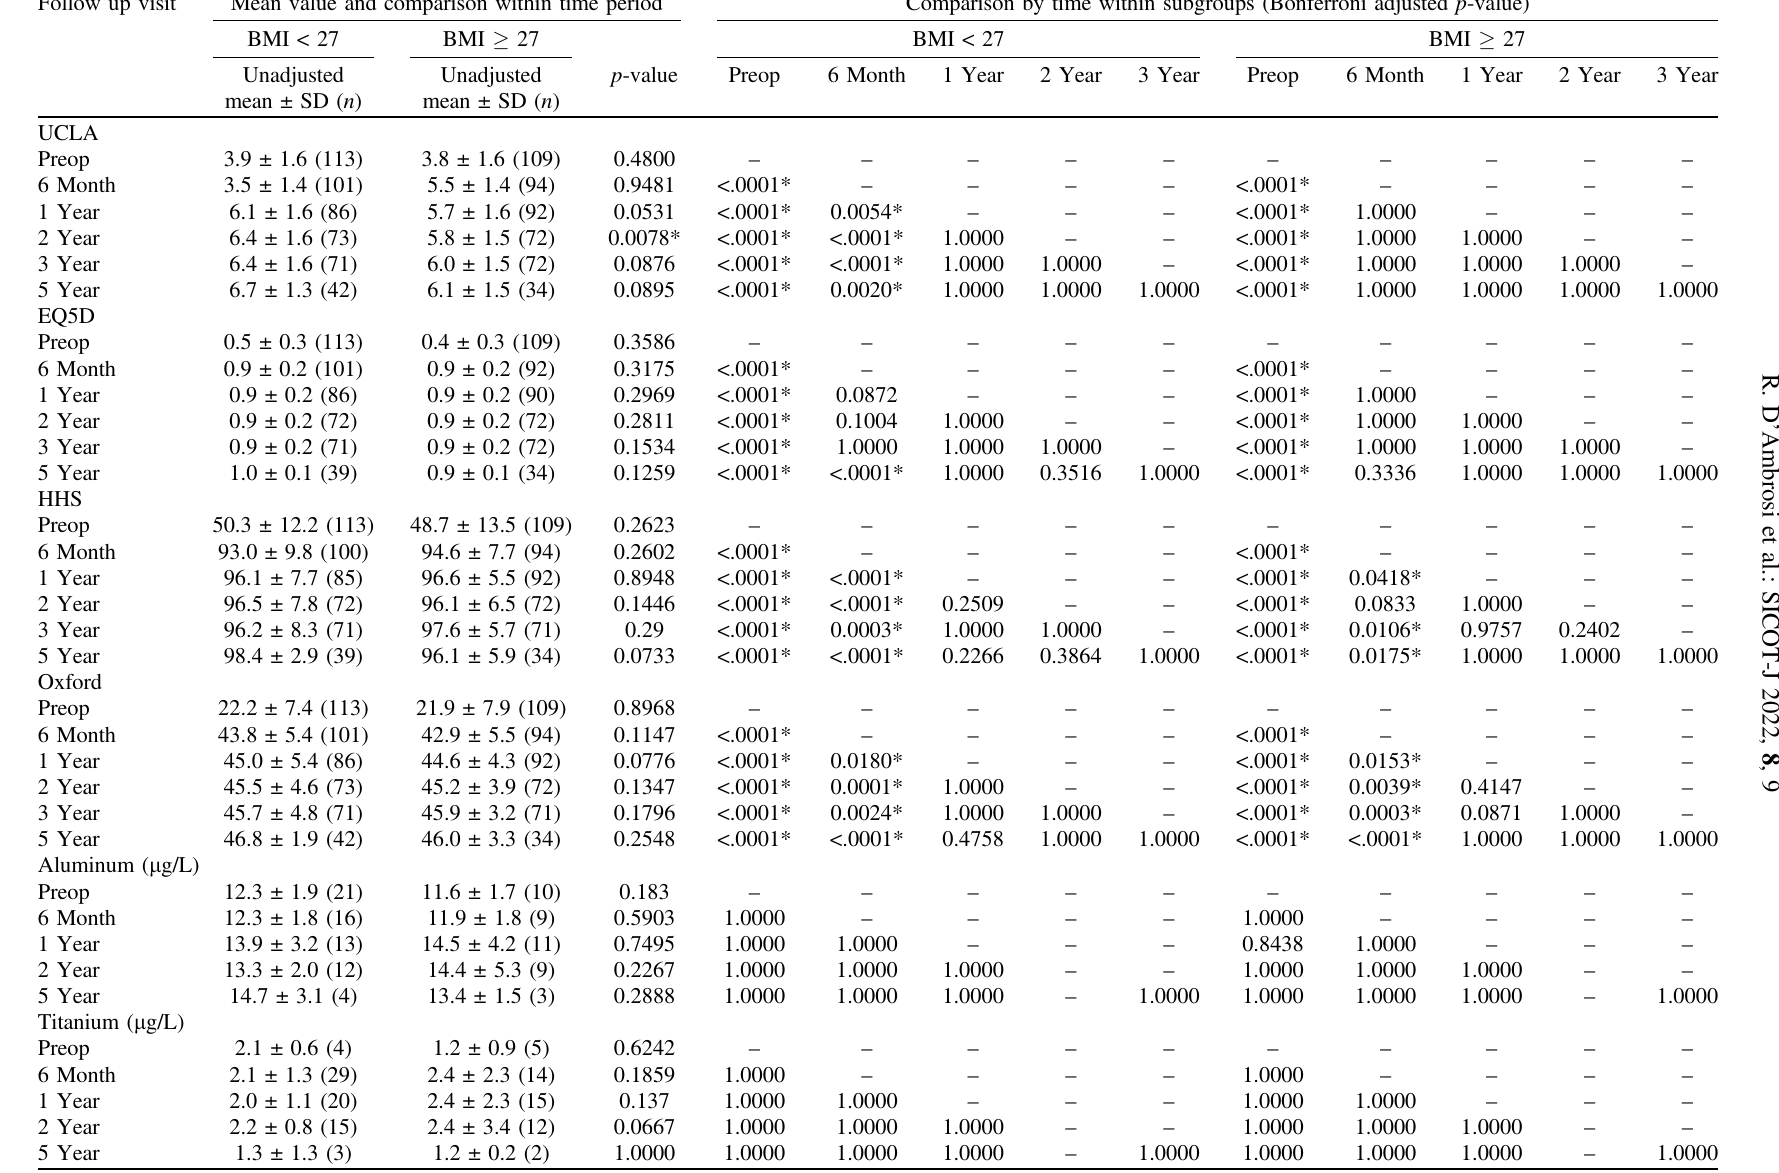
Table A.6. Subgroup analysis by